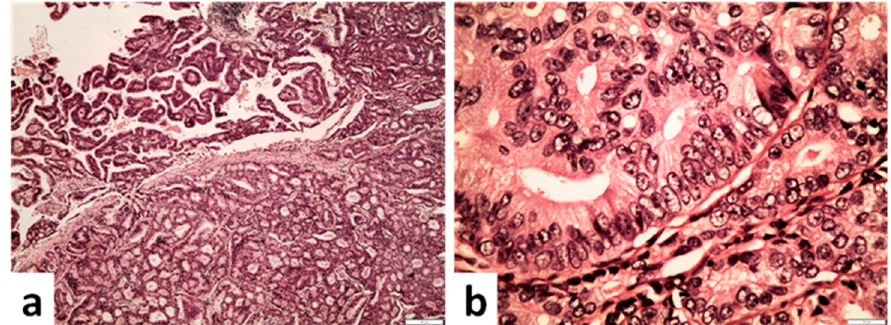
Figure 5. Ductal carcinoma of the prostate. ( a ) Papillary and cribriform architecture coexisting in a ductal adenocarcinoma of the prostate gland (×40). ( b ) Columnar tumor cells within a cribriform structure compatible with ductal carcinoma (×400) (scale bar is 50 μ m).